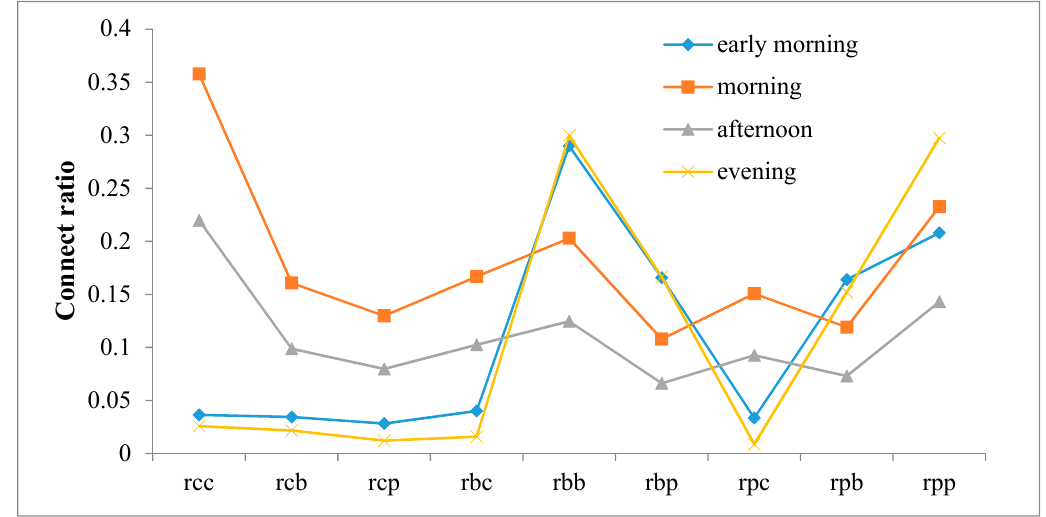
Figure 7. Distribution connection ratio of the core layer, the bridge layer, and the periphery layer on weekdays.